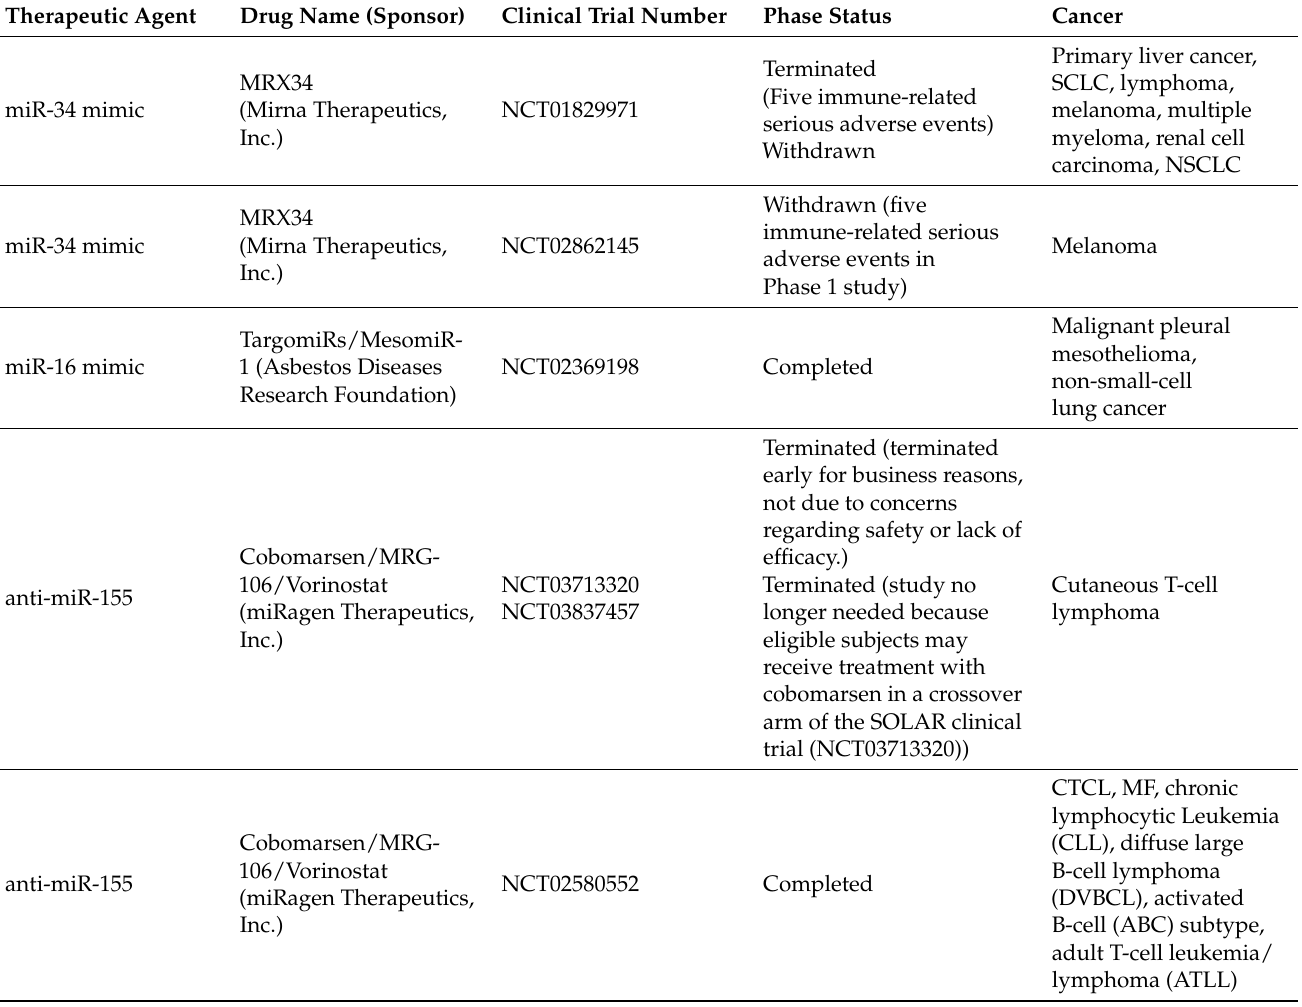
Table 4. Clinical trials of miRNA therapy in oncology (based on https://clinicaltrials.gov, accessed on 10 January